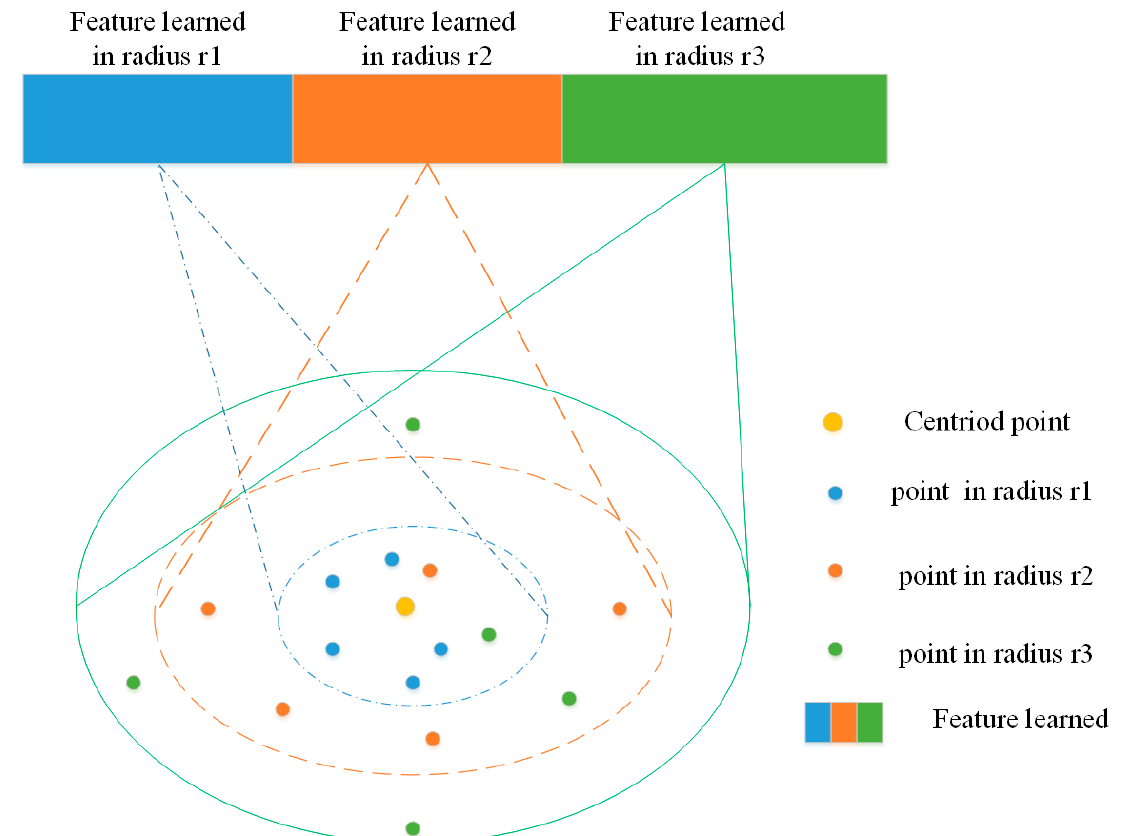
Figure 1. Feature learning with (Multi-scale grouping) MSG methods. The yellow point represents the centroid point whilst the blue, orange and green points represent the sample points in radius r1, r2, and r3, respectively. The rectangle represents the feature vector concatenated at different scales for future processing.